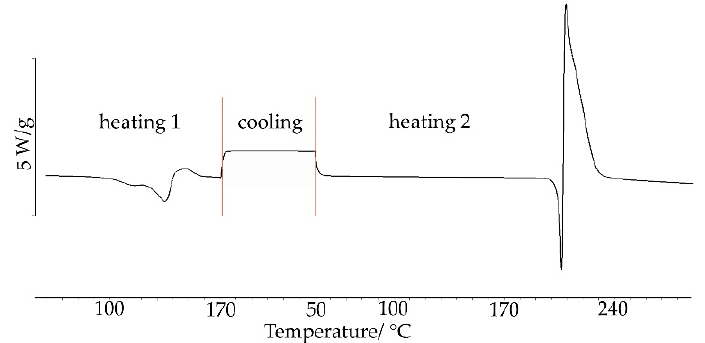
Figure 8. DSC curve for chlordiazepoxide mixture with saccharin prepared by the grinding with ACN for 30 min. Measurements were taken in nitrogen using heating, cooling, and re-heating programs.